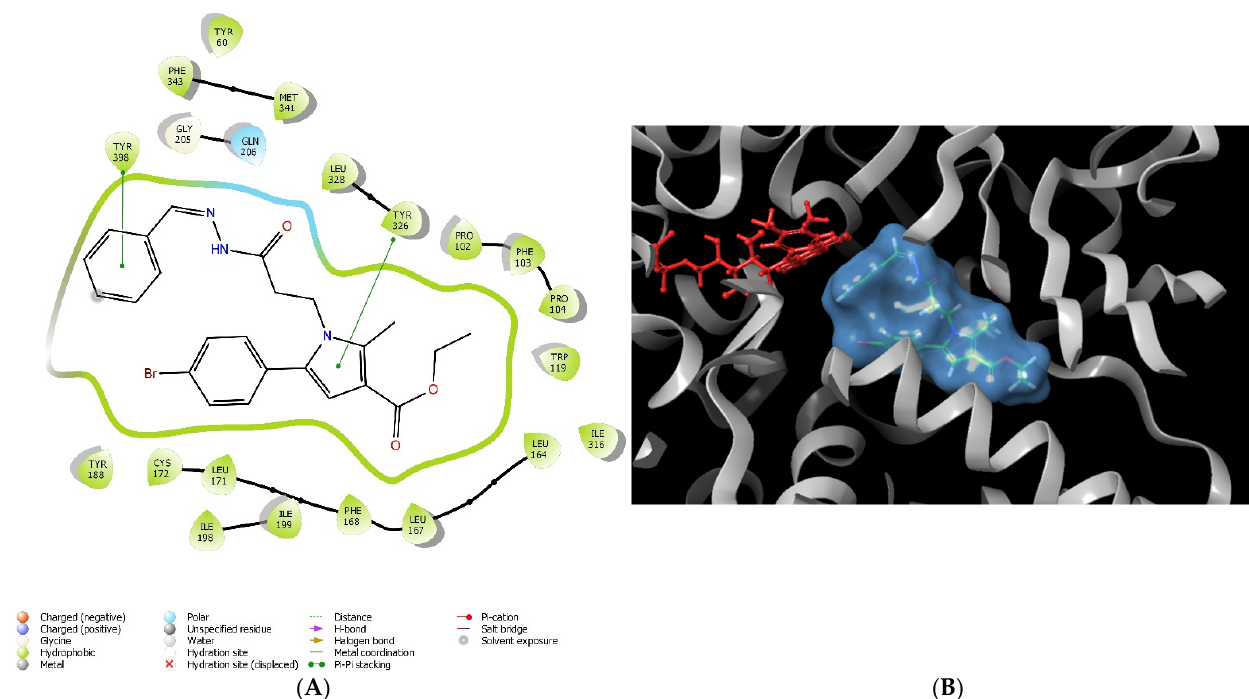
Figure 2. Major molecular interactions between 12a and the active site of MAO ‐ B (PDB: 1S3B ). The interactions are provided in 2D ( A ) and 3D ( B ) forms. The MAO ‐ B enzyme is depicted in grey, the FAD coenzyme is colored in red, and the MAO ‐ B inhibitor 12a is presented in blue mesh.